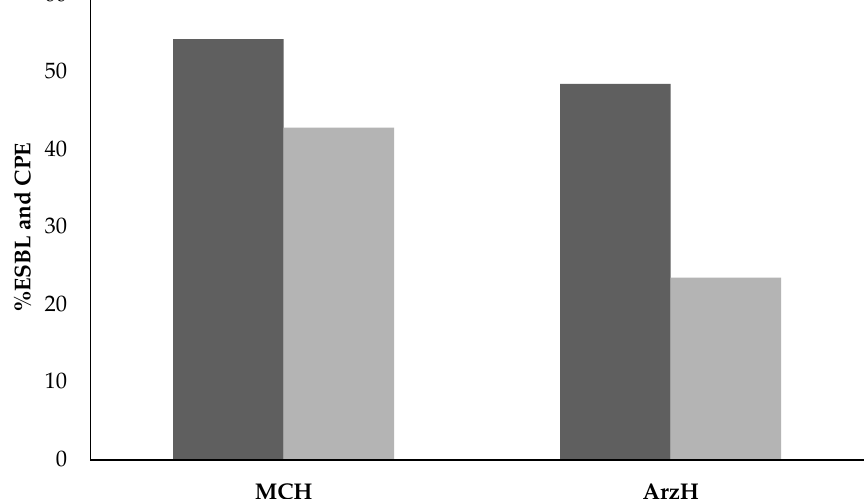
Figure 5. Percentage of extended-spectrum betalatamase-producing enterobacteria (ESBL) ( (cid:4) ) and